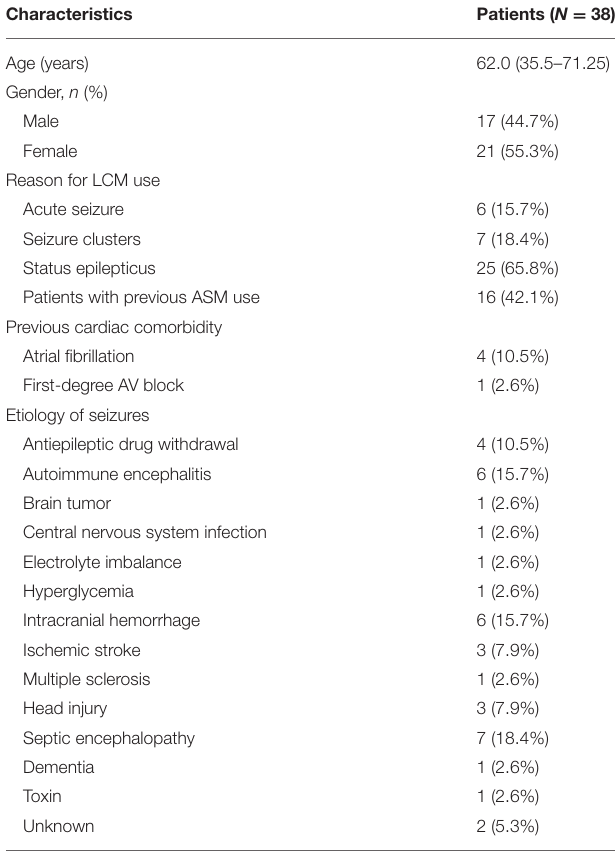
TABLE 1 | Demographic data of patients using